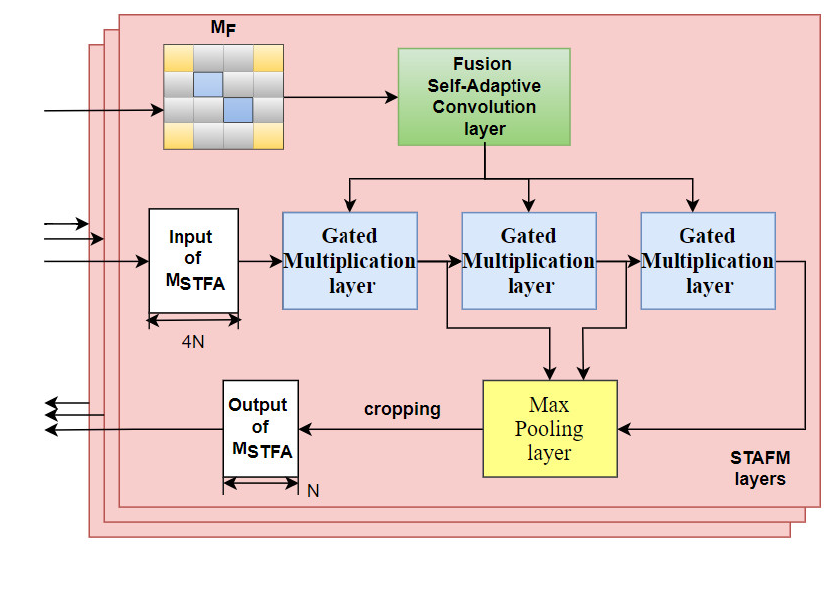
Figure 2. Construction of a layer in STAFM module, in